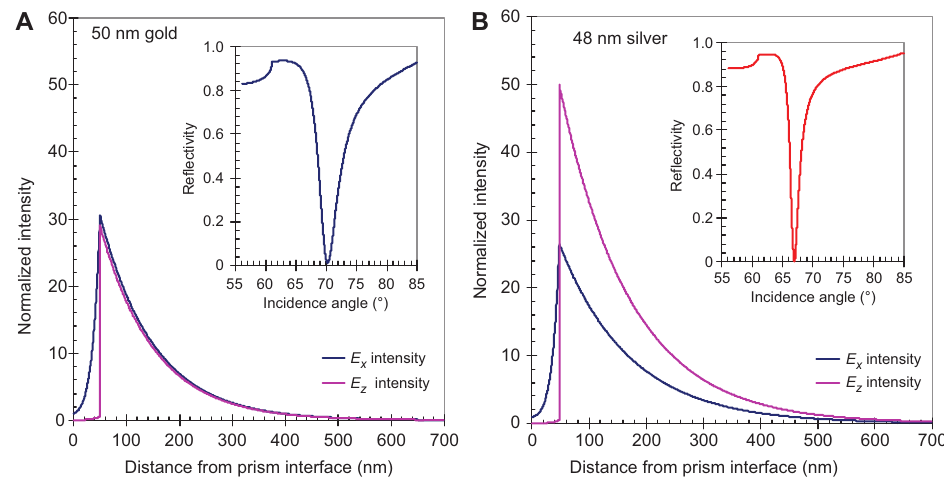
Figure 4 Electromagnetic fi eld intensity distributions with increasing distance from the prism interface using Kretschmann confi guration for: (A) 50 nm gold; and (B) 48 nm silver fi lms. E insets present the refl ectivity profi les for both cases.